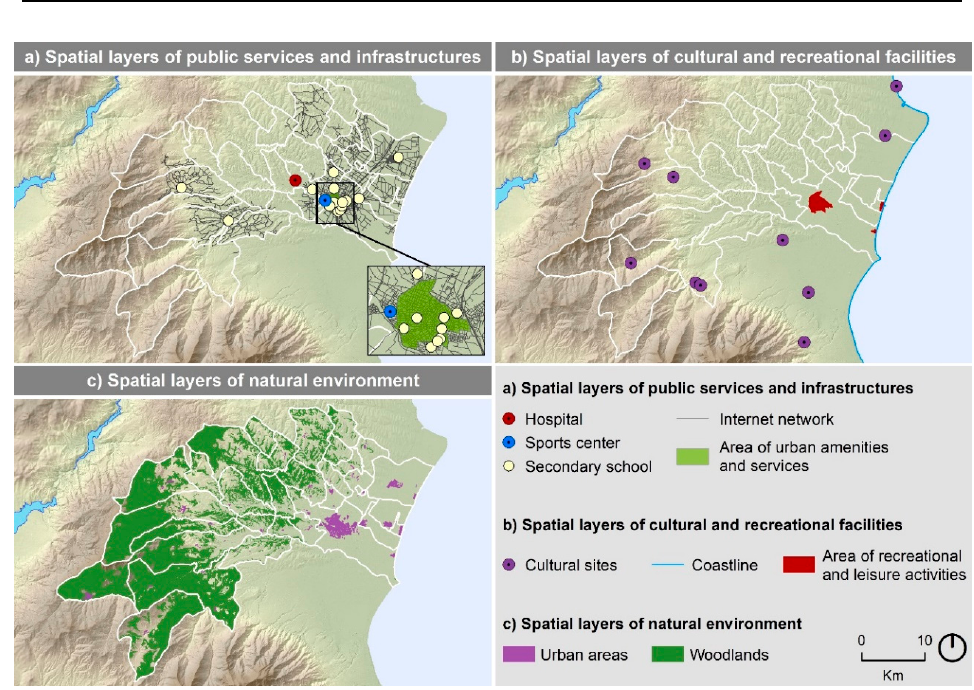
Figure 3. Spatial layers of factors per criterion. ( a ) spatial layers of public services and infrastructures, ( b ) spatial layers of cultural and recreational facilities, ( c ) spatial layers of natural environment.